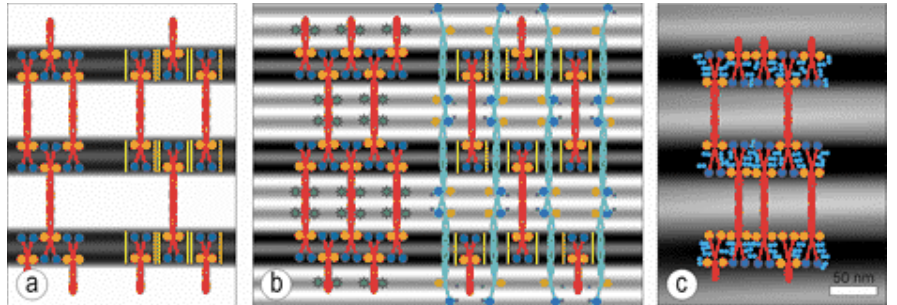
FIGURE 5. Models for the collagen VI tetramer packing superimposed on one-dimensional averages of the electron densities from the structures described in Fig. 4a,c, and d. Collagen VI tetramers are represented in red. N- and C-terminals are represented in blue and orange. Dimers are in light blue. (a) Left: Model for the assembly associated with Full Thickness Macular Holes: the packing occurs through the globular domain interactions, N-terminals interacting with the C-terminals and vice versa. Right: extra material (yellow bars) binding to the collagen VI tetramer outer segments could increase the electron density in this region. (b) Model for the assembly associated with Age- Related Macular Degeneration: the extra pairs of bands may arise from globular proteins binding to the tetramer triple helices (left; green stars) or more likely from the globular domains of dimers associating laterally with the tetramers (right). (c) Model for the assembly associated with Sorsby’s Fundus Dystrophy. TIMP3 molecules (represented by blue circles) associate with the tetramer outer segments and fill the space between the